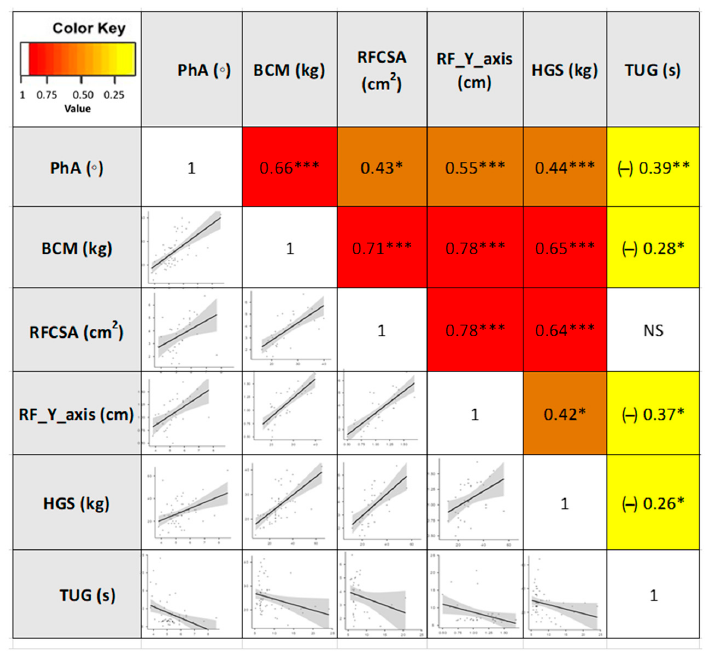
Figure 4. Heatmap correlation matrix and plot of the morphofunctional parameters in cancer pa-